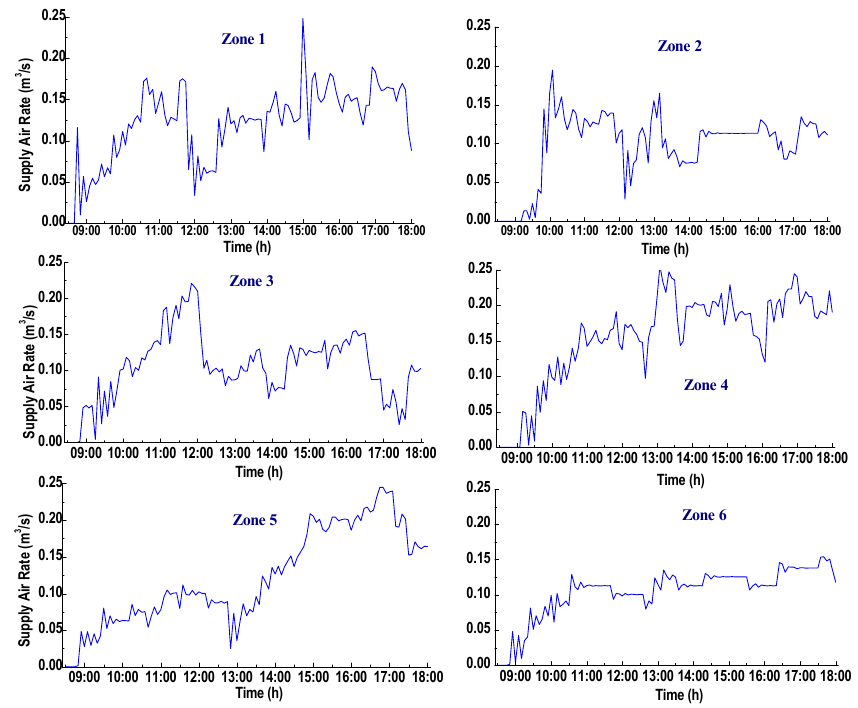
Figure 5. Supply air rate of six zones under Scenario 1.